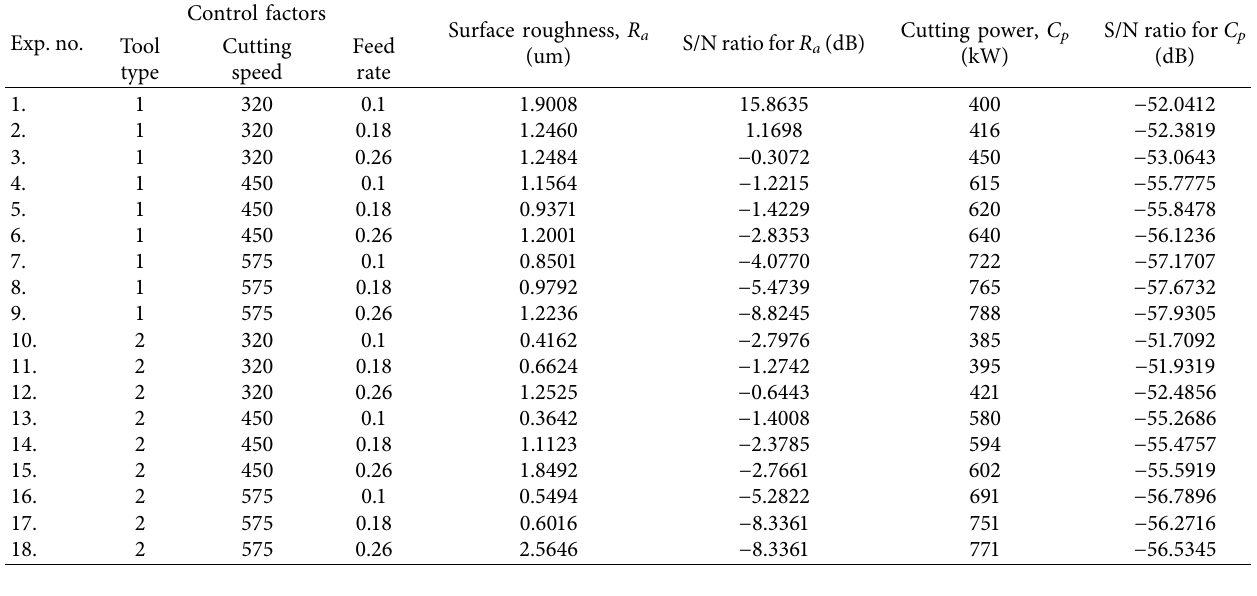
Table 5: S/N response table for R